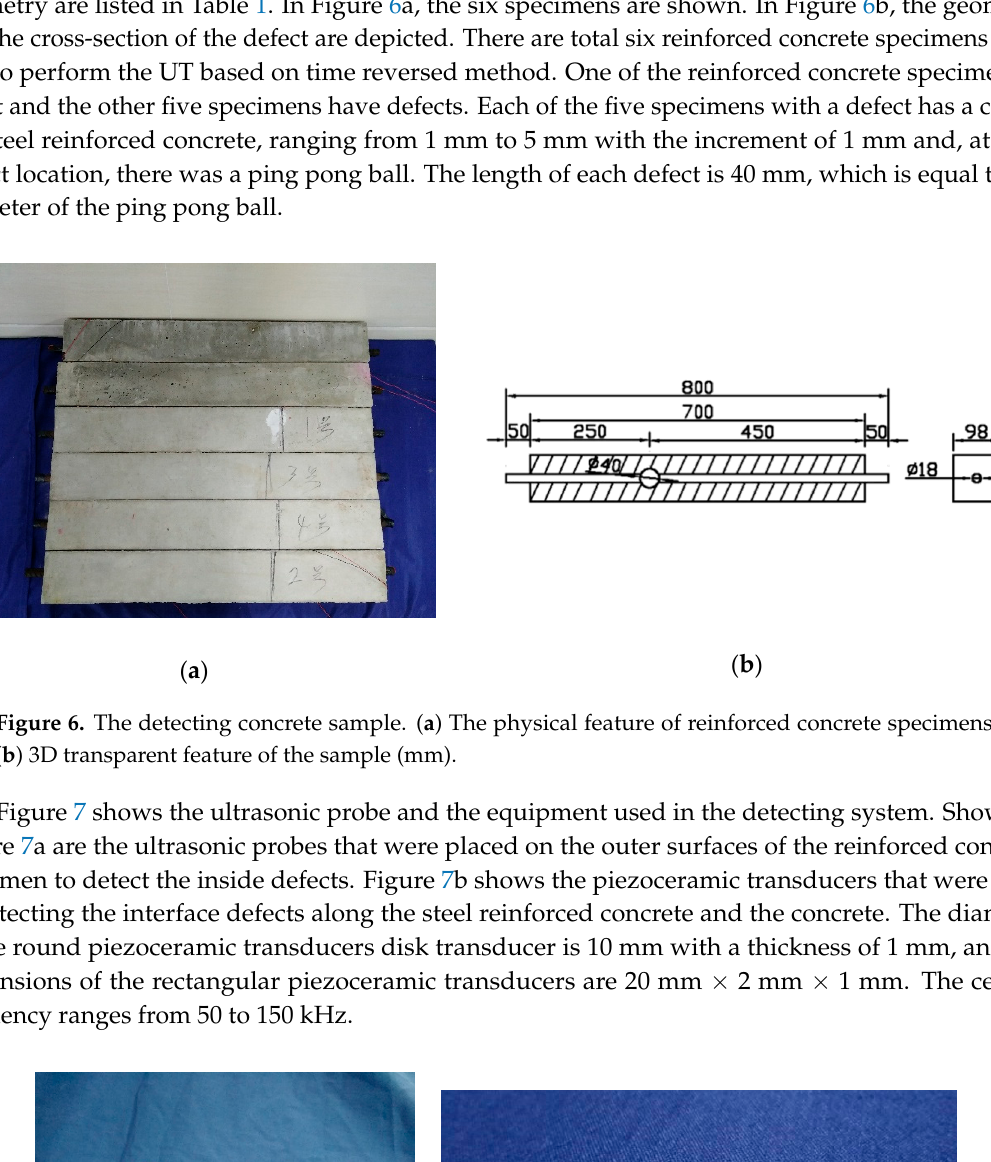
Figure 7. The transducers used in the detecting system. ( a ) Ultrasonic probe. ( b ) piezoceramic transducers.